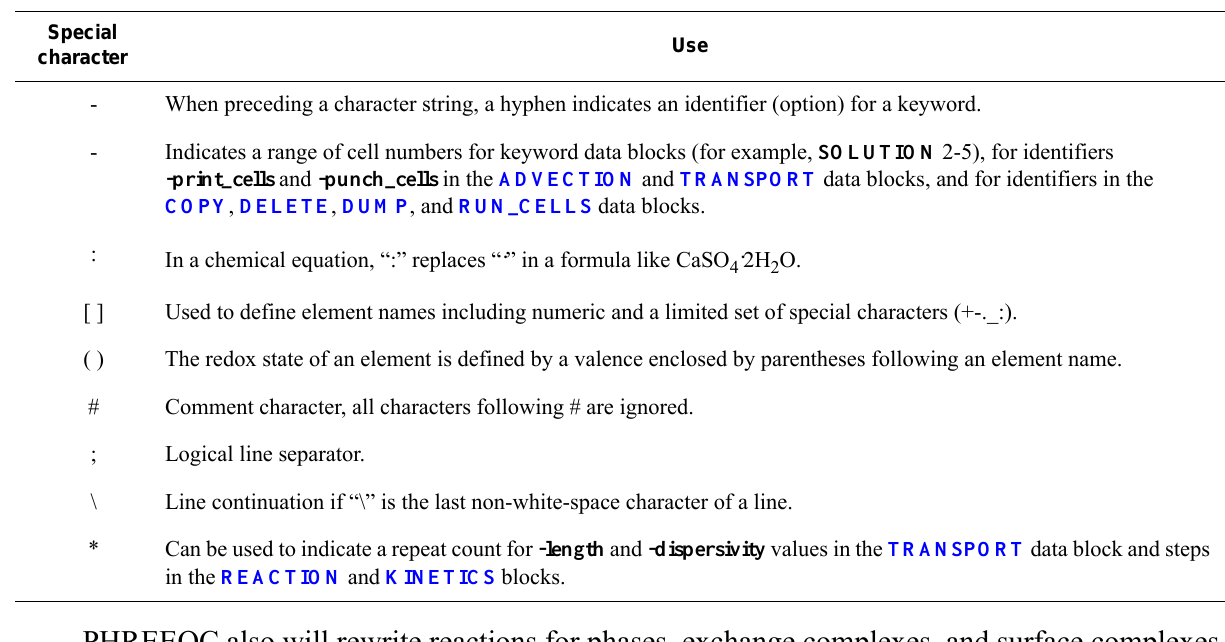
Table 2. Summary of special characters for input data